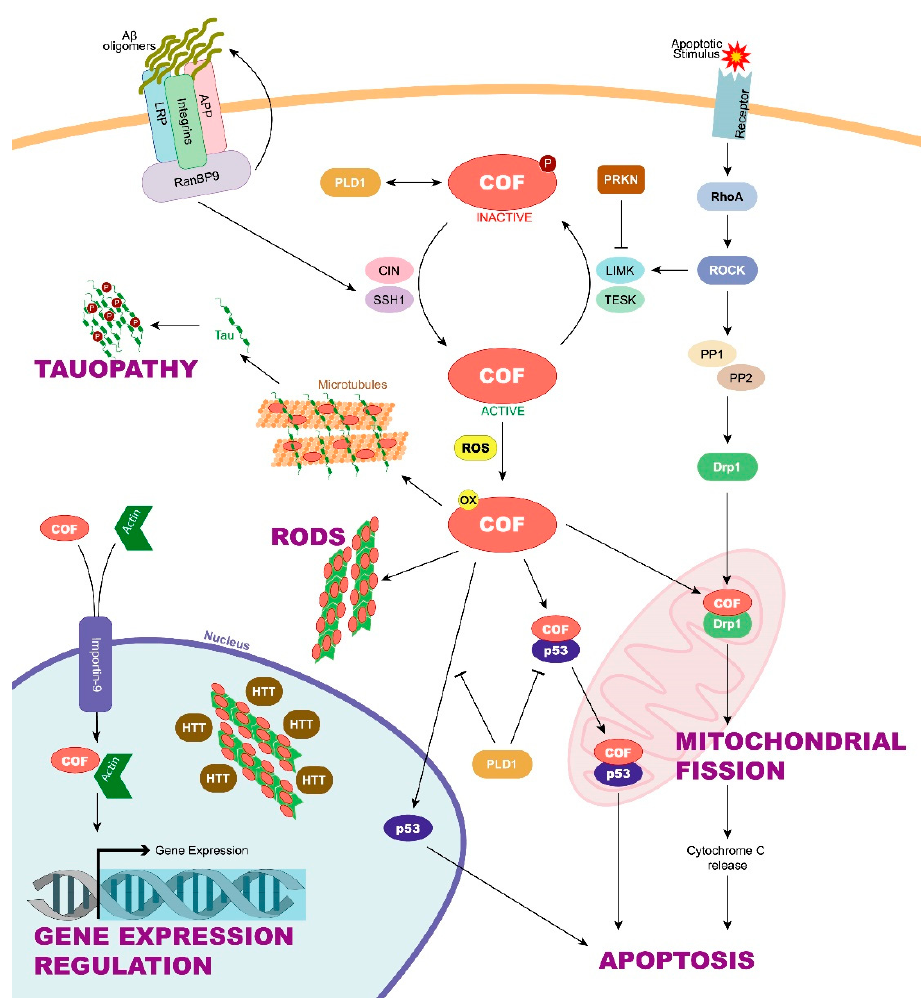
Figure 2. Role and regulation of cofilin in neurodegeneration. Cofilin function depends on the phosphorylation of its Ser3 residue, among others. When Ser3 is dephosphorylated by CIN and SSH1, cofilin enters an active state that can be enhanced by A β oligomer accumulation. On the other hand, LIMK and TESK can phosphorylate, and thus, inactivate cofilin. Parkin can interfere with cofilin phosphorylation by blocking LIMK function. Under oxidative stress conditions, active and oxidized cofilin can be translocated into the mitochondria, allowing it to take part in mitochondrial fission. This process is mediated by both active cofilin and the DRP1 protein and can be induced by activation of the ROCK pathway. Mitochondrial fission, in turn, triggers the release of the cytochrome C, leading to apoptosis. Apoptosis can also begin with the cofilin/p53 pathway, although inactive cofilin can prevent it activating PLD1. Moreover, active and oxidized cofilin can form cofilin–actin rods. The rods have been found to colocalize in the nucleus with huntingtin. Cofilin can also enter the nucleus together with actin through importin-9. Once in the nucleus, cofilin and actin can regulate gene expression. Finally, cofilin competes with tau for microtubule binding, displacing tau and promoting tauopathies. A β , amyloid β ; APP, amyloid precursor protein; CIN, chronophin; COF, cofilin; Drp1, dynamin-related protein 1; HTT, huntingtin; LIMK, LIM-domain containing kinase; PLD1, phospholipase D1; PP1/PP2, protein phosphatase 1 and 2; PRKN, parkin; SSH1, slingshot; TESK, testis-specific kinase.